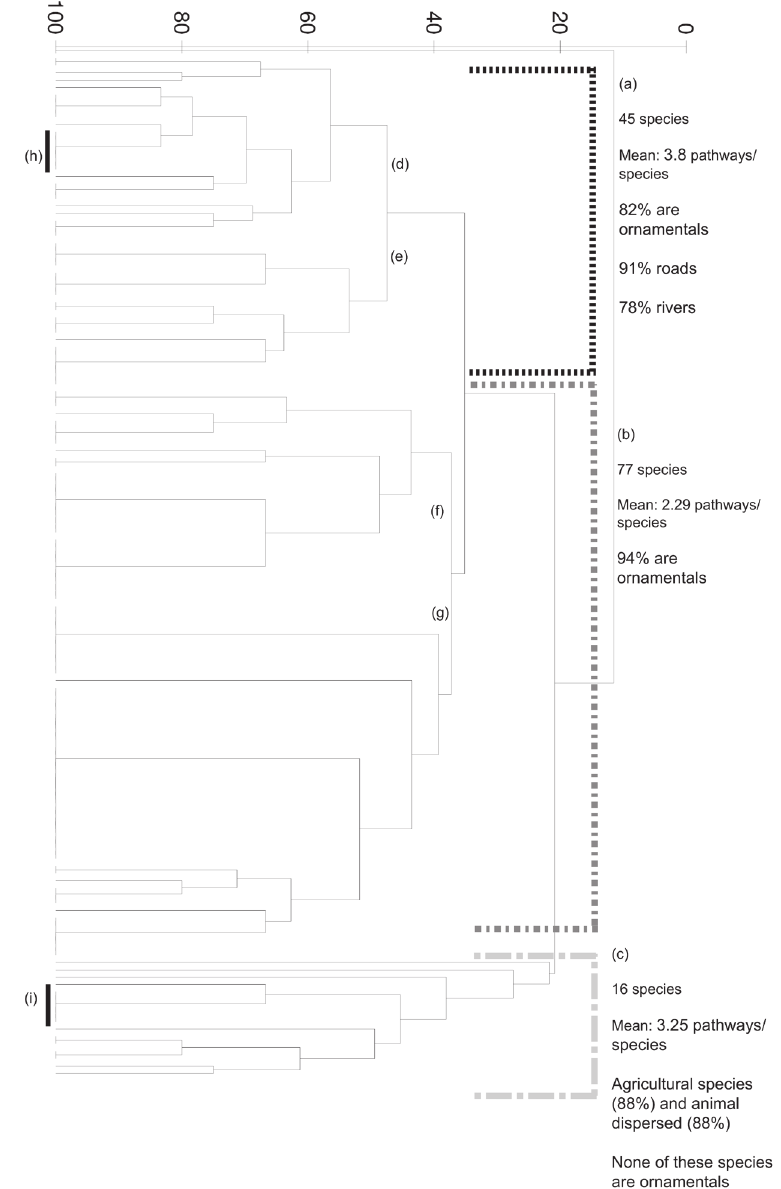
Figure 3. Cladogram of plant introduction pathways, based on similarities of pathways. Mean number and type of pathways have been calculated per clade (Groups a–c ). Sub-groups d include 25 species (Mean: 4.5 pathways/species; 100% contaminants; 92% rivers; 84% roads; 80% ornamentals) e include 20 species (Mean: 2.9 pathways/species; 100% roads; 85% ornamentals) f include 29 species (Mean: 2.5 pathways/ species; 96% ornamentals; 90% animals) g include 48 species (Mean: 2.1 pathways/species; 91% ornamen- tals). The vertical black bars indicate clustering of species, whereas all other species are scattered across the groups h Acacia podalyriifolia , A. baileyana , A. elata , A. implexa , A. longifolia i Pinus pinaster , P. radiata , P. roxburghii , P. taeda , P. halepensis , P.